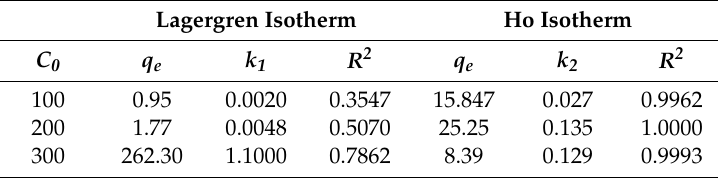
Figure 14. Pseudo-secondorderkinetic(Ho)modelforAB92adsorptionontoNd 2 O 3 nanoparticlesat298K. Table 6. Kinetics parameters for adsorption of AB92 onto Nd 2 O 3 nanoparticles.